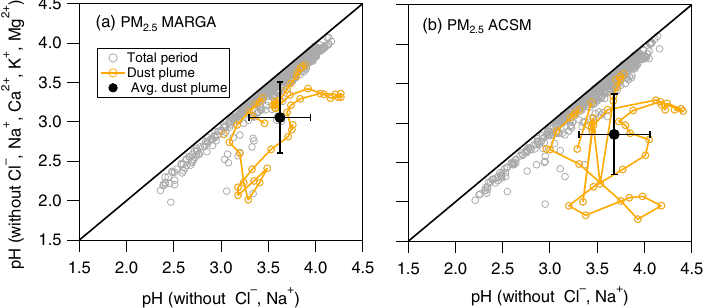
Figure 7. Comparison of predicted fine aerosol pH with and without Ca 2 + , K + , and Mg 2 + as model inputs, for the PM 2 . 5 -ACSM and PM 2 . 5 -MARGA, respectively. The dust plume has been marked in Fig. S7, during the period of which the PM 2 . 5 -MARGA pH increased from 3 . 06 ± 0 . 45 to 3 . 62 ± 0 . 32, and the PM 2 . 5 -ACSM pH increased from 2 . 86 ± 0 . 51 to 3 . 70 ± 0 . 37.